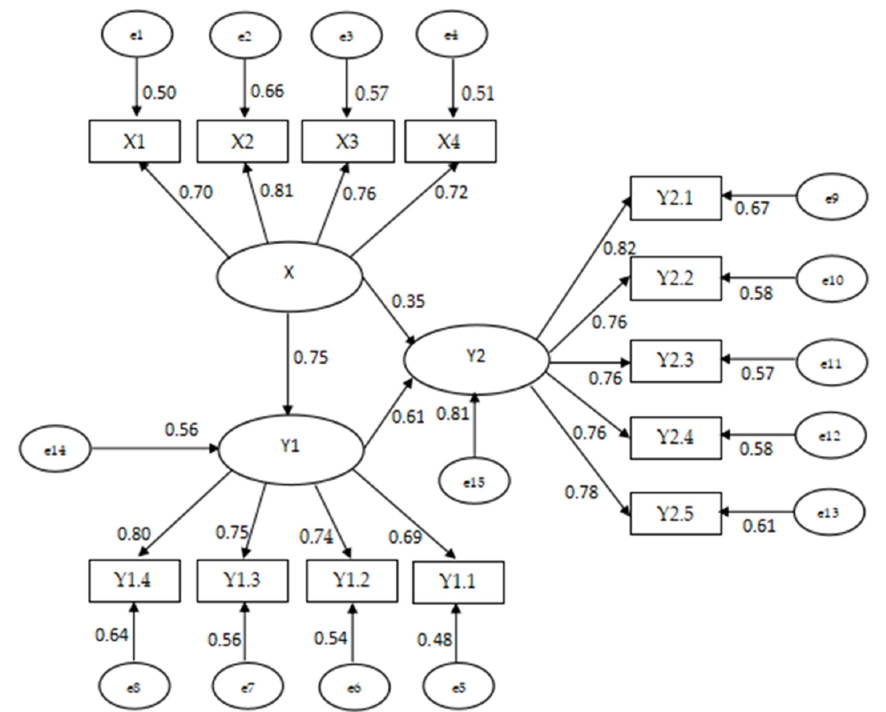
Figure 2. Structural model.